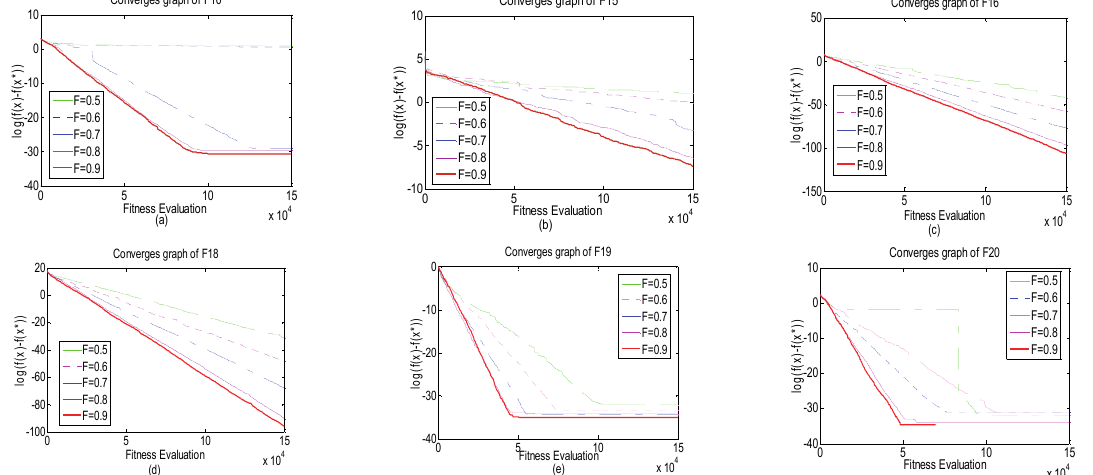
Fig. 3. Convergence graphs of six different benchmark function: (a) F10, (b) F15, (c) F16, (d) F18, (e) F19, (f)